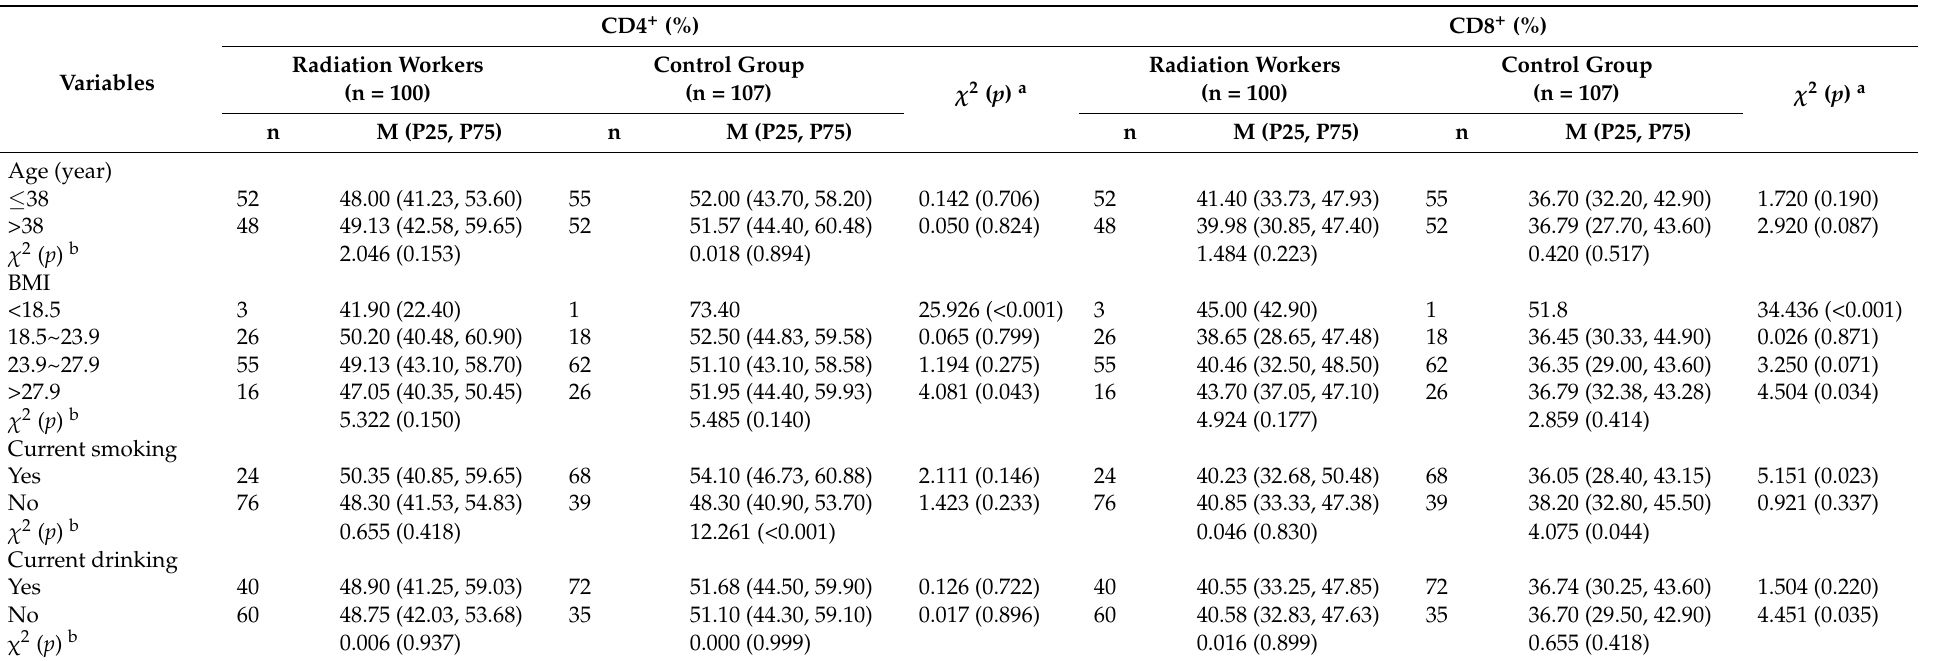
Table 4. Relationship between demographic characteristics and percentage of CD4+ and CD8+cells.